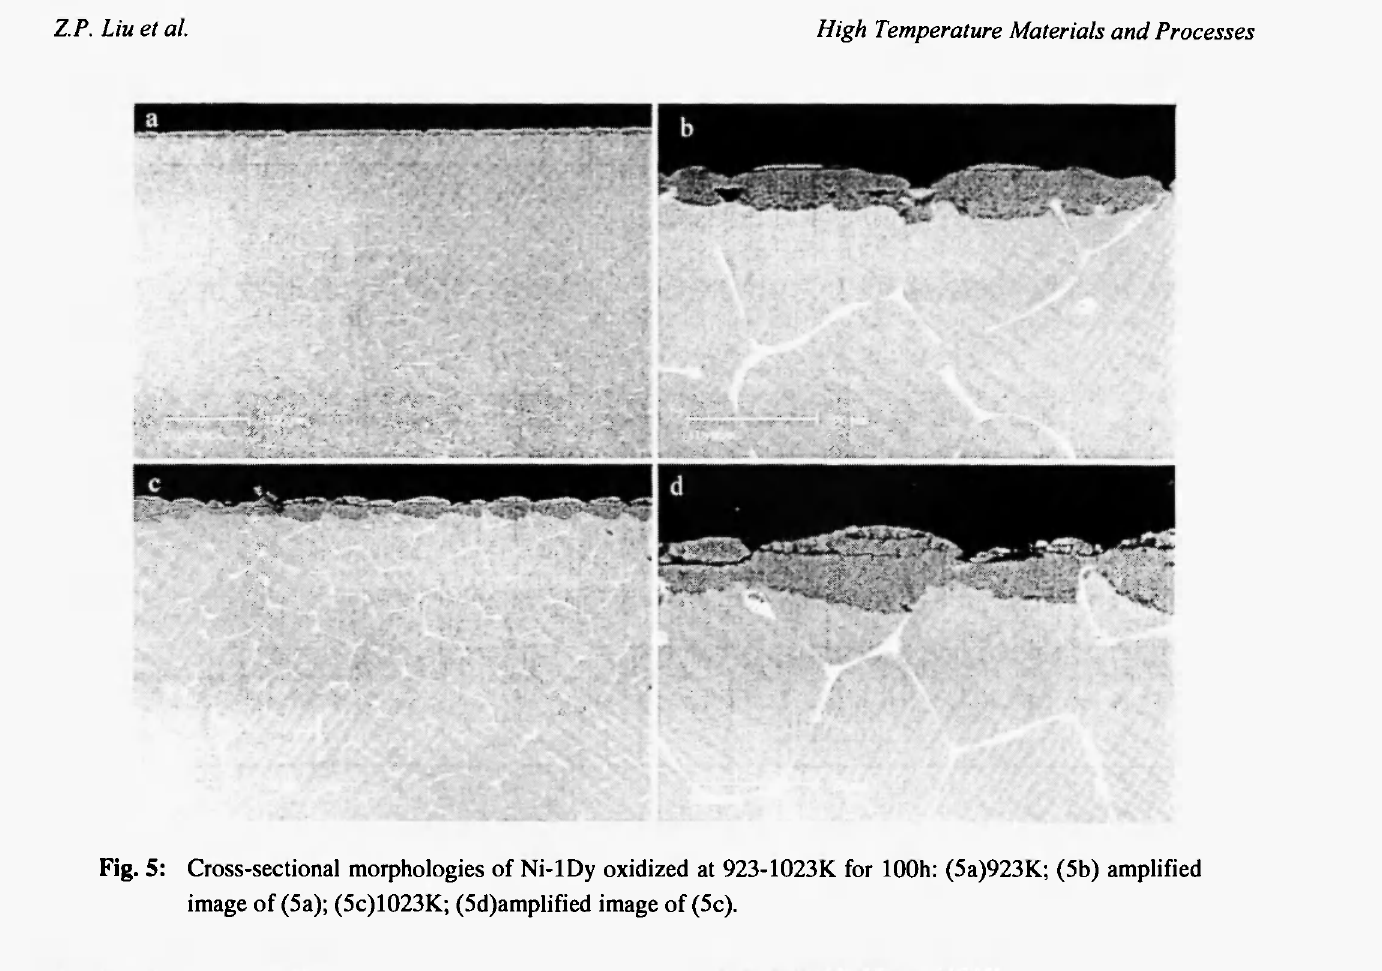
Fig. 5: Cross-sectional morphologies of Ni-lDy oxidized at 923-1023K for 100h: (5a)923K; (5b) amplified image of (5a); (5c)1023K; (5d)amplified image of